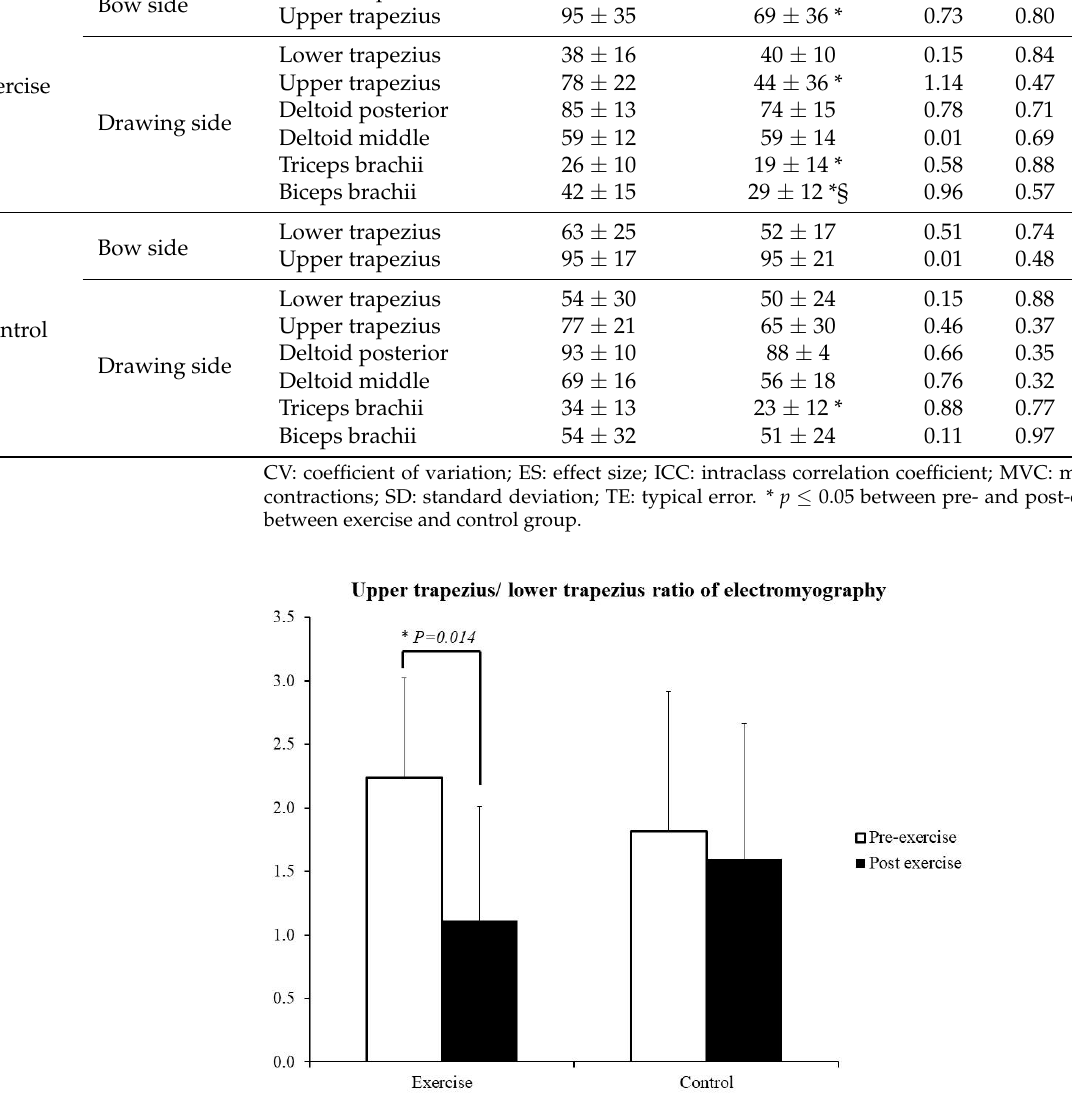
Table 2. Before releasing EMG %MVC. Pre-Exercise